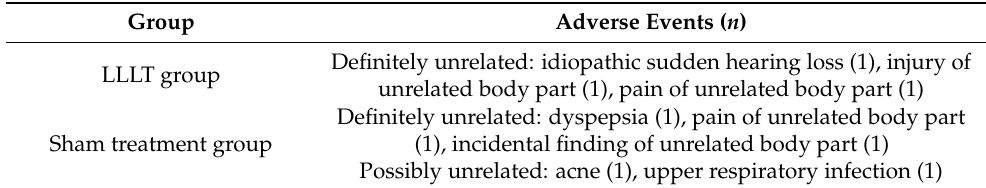
Table 7. Reported adverse events associated with LLLT and sham treatment